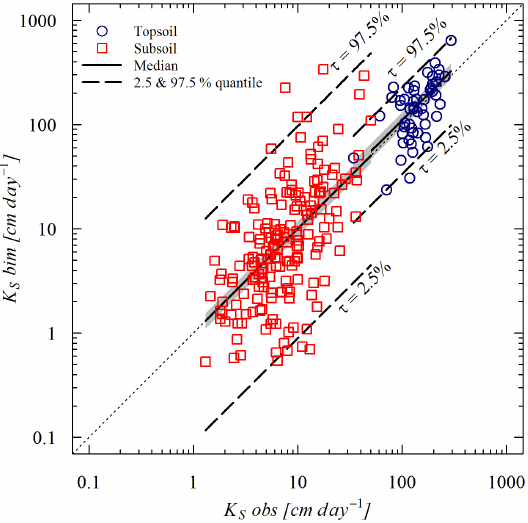
Figure 4. Error of K s_bim plotted against K s_obs for topsoil and subsoil. The solid line refers to the median line for each group, the dashed line refers to the upper or lower 95% confidence interval lines, the dotted line refers to the 1 : 1 correspondence line, and the shaded region is the 95% confidence interval of the median esti-